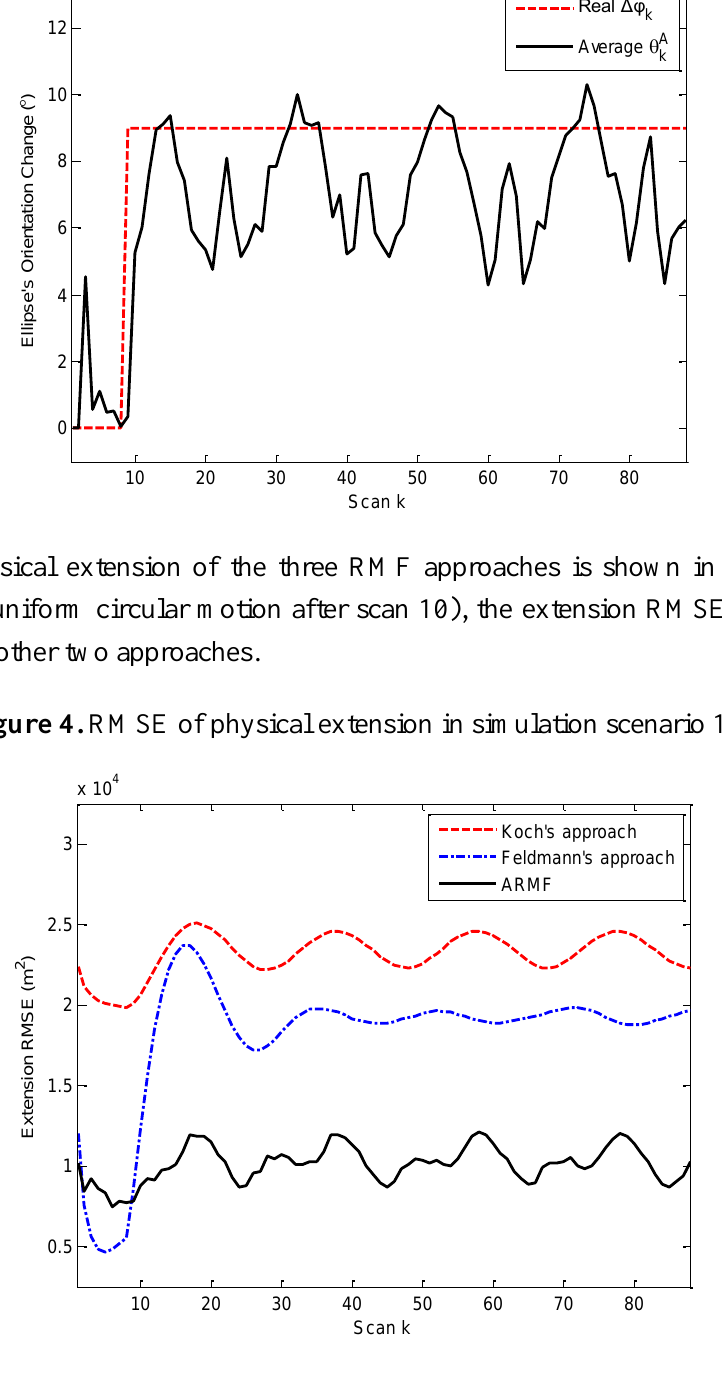
Figure 3. Average